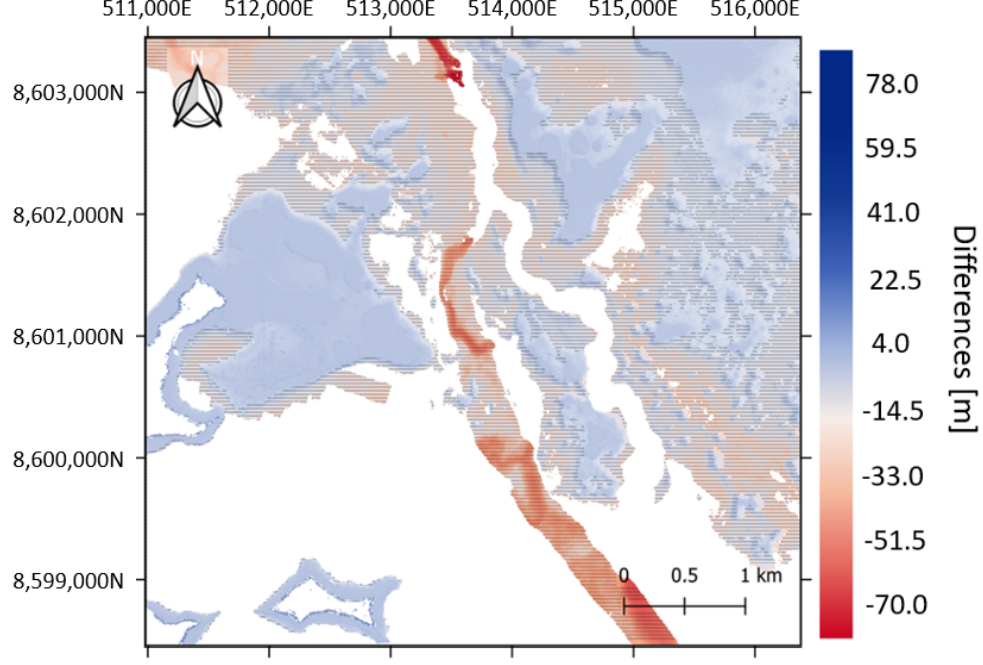
Figure 13. Map of the differences between the DDM derived from the Litto3D ® and the ICESat- 2/Pleiades-1 fusion.